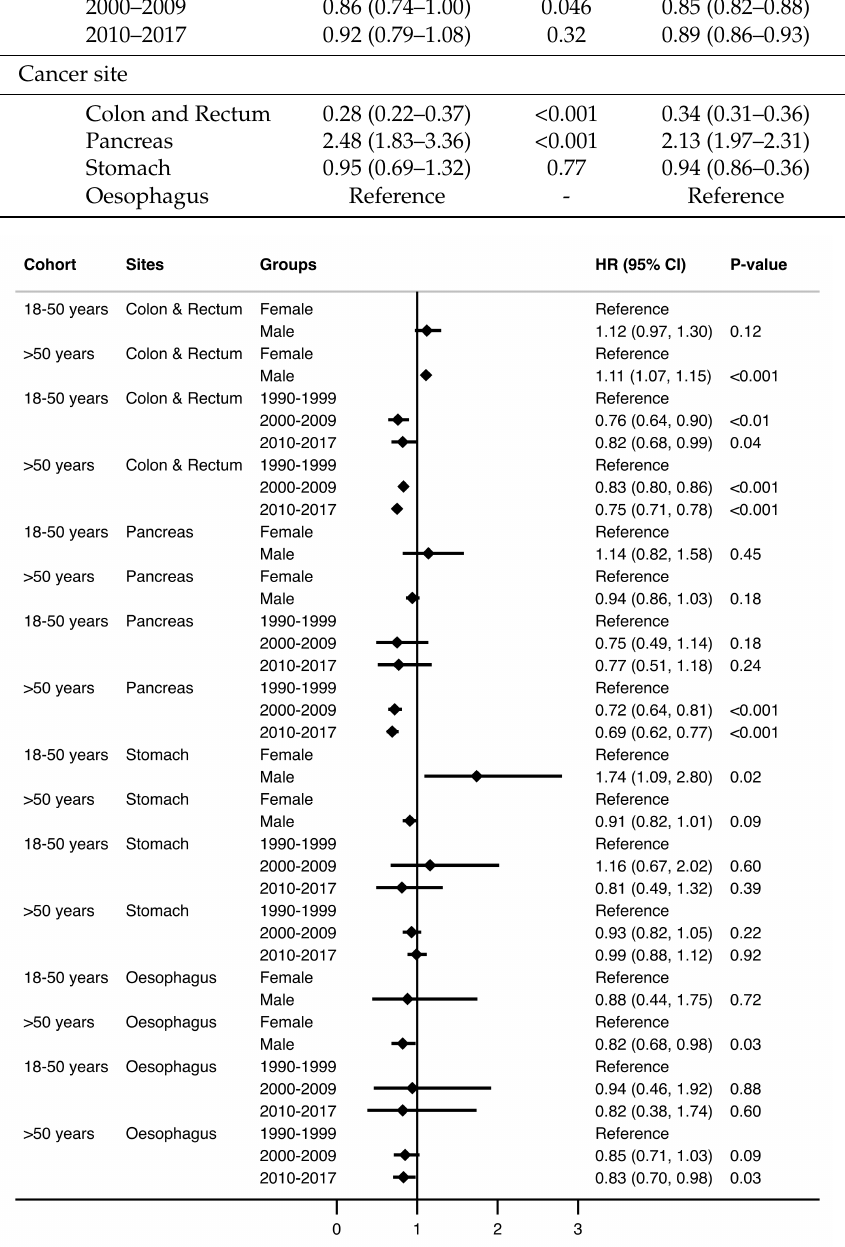
Figure 3. Hazard ratios (HR) and 95% CI (Cox proportional hazard model) for sex and era by primary sites between two age groups ( n =